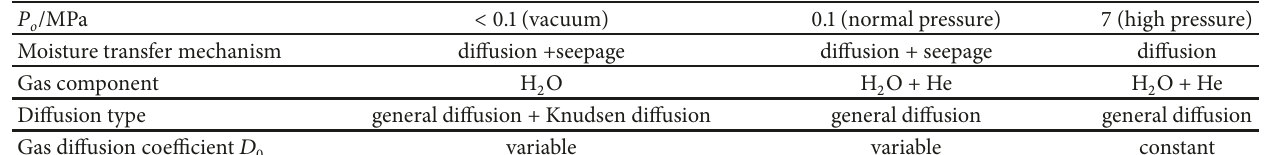
Table 3: Comparison of transfer mechanisms at different pressure.